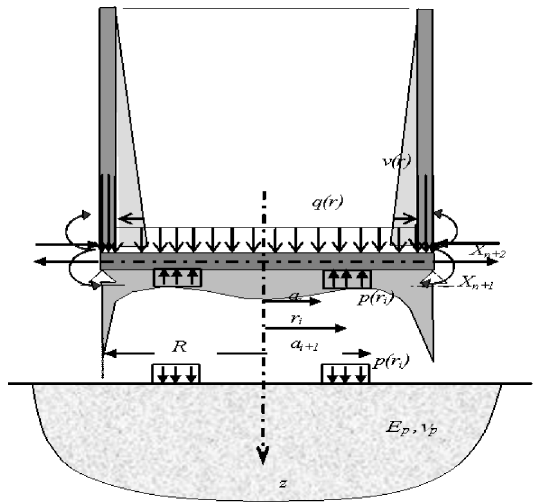
Fig. 2. Model of the cylindrical